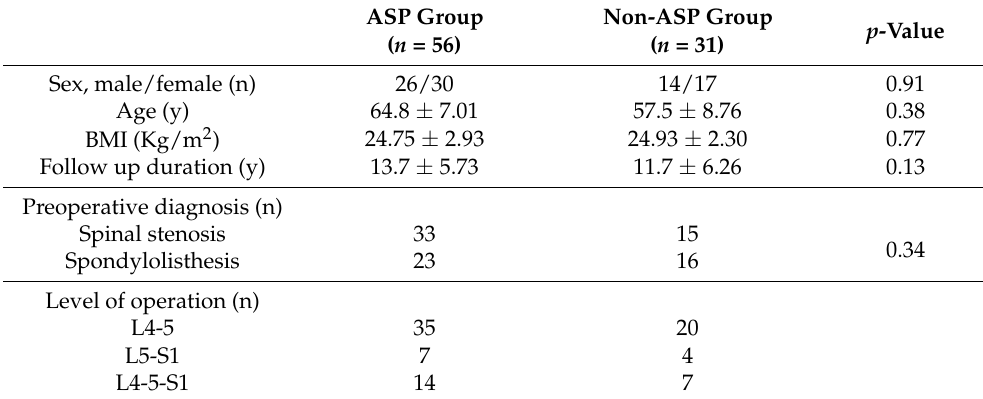
Table 1. Preoperative demographic data.